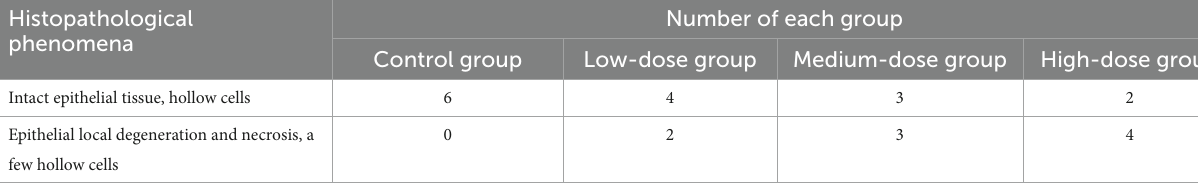
TABLE 4 Results of histopathological examination of wart xenografts ( n = 6 each